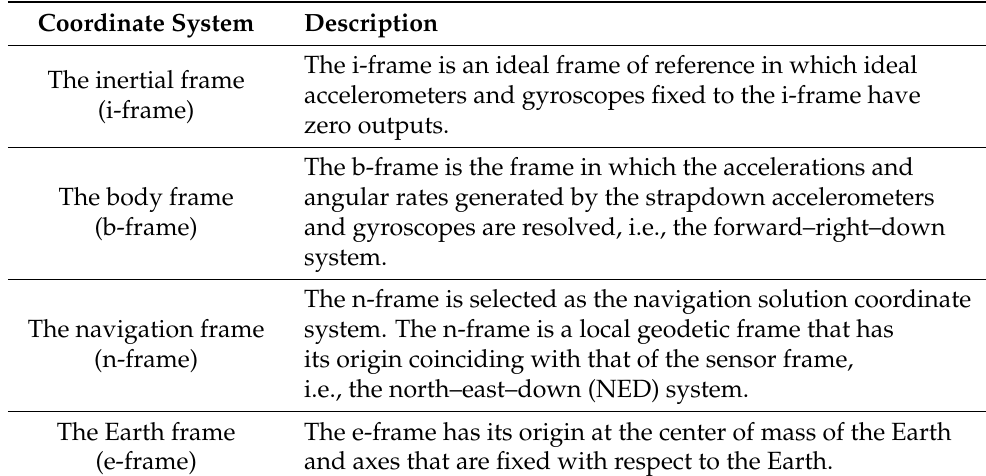
Table 1. Description of the coordinate